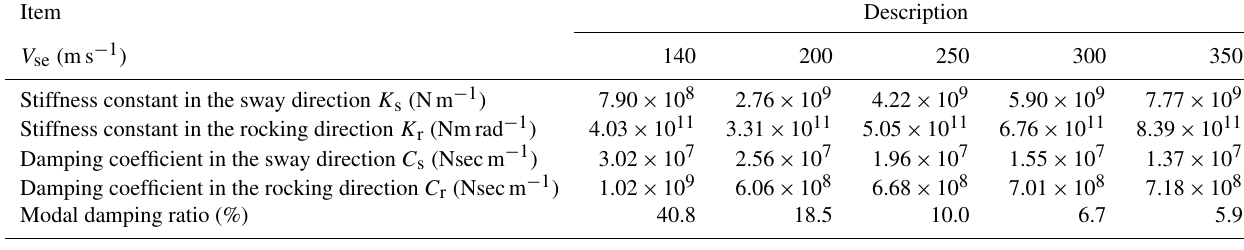
Table 9. The outline of the piled-foundation-supported wind turbines with different rated powers. Item